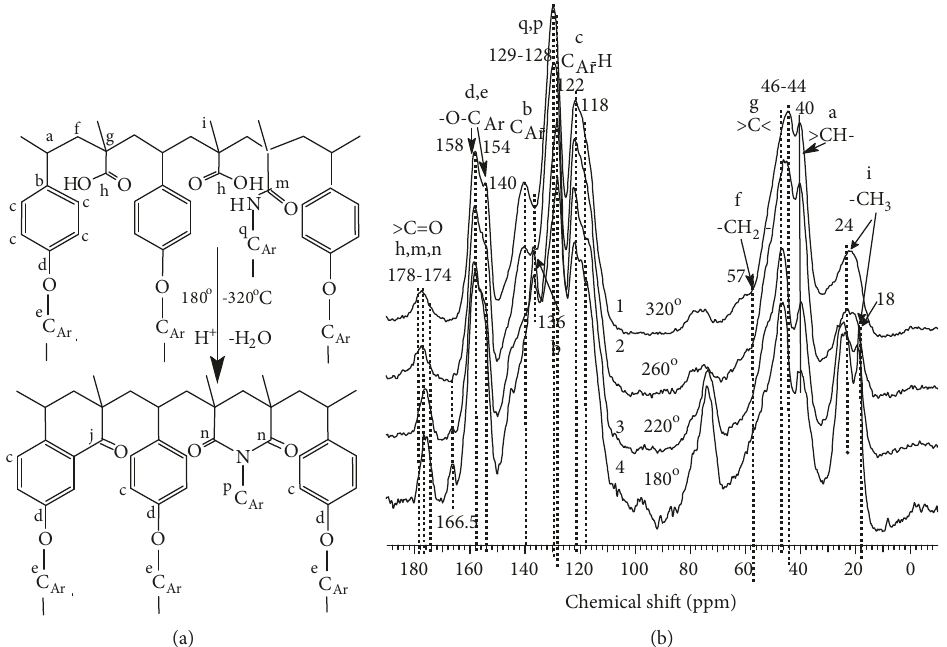
Figure 7: Schematic representation of interaction between ADA and restructurized ROL copolymers; 13 С NMR spectra of the samples of ROL-II- (85 wt.%) 1,3-BAPB (15 wt.%) cured in the thermal regime up to the following T